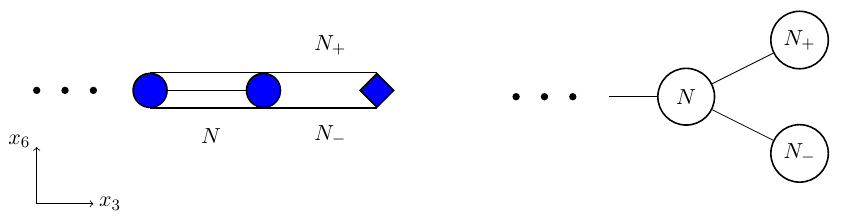
Figure 53 . Type IIB realization of the bifurcated tail of a D -type quiver with unitary gauge groups. The blue circular nodes denote NS5-branes, while the blue rhombus denotes an Orb-5 plane. The D3-branes are denoted by black horizontal lines.